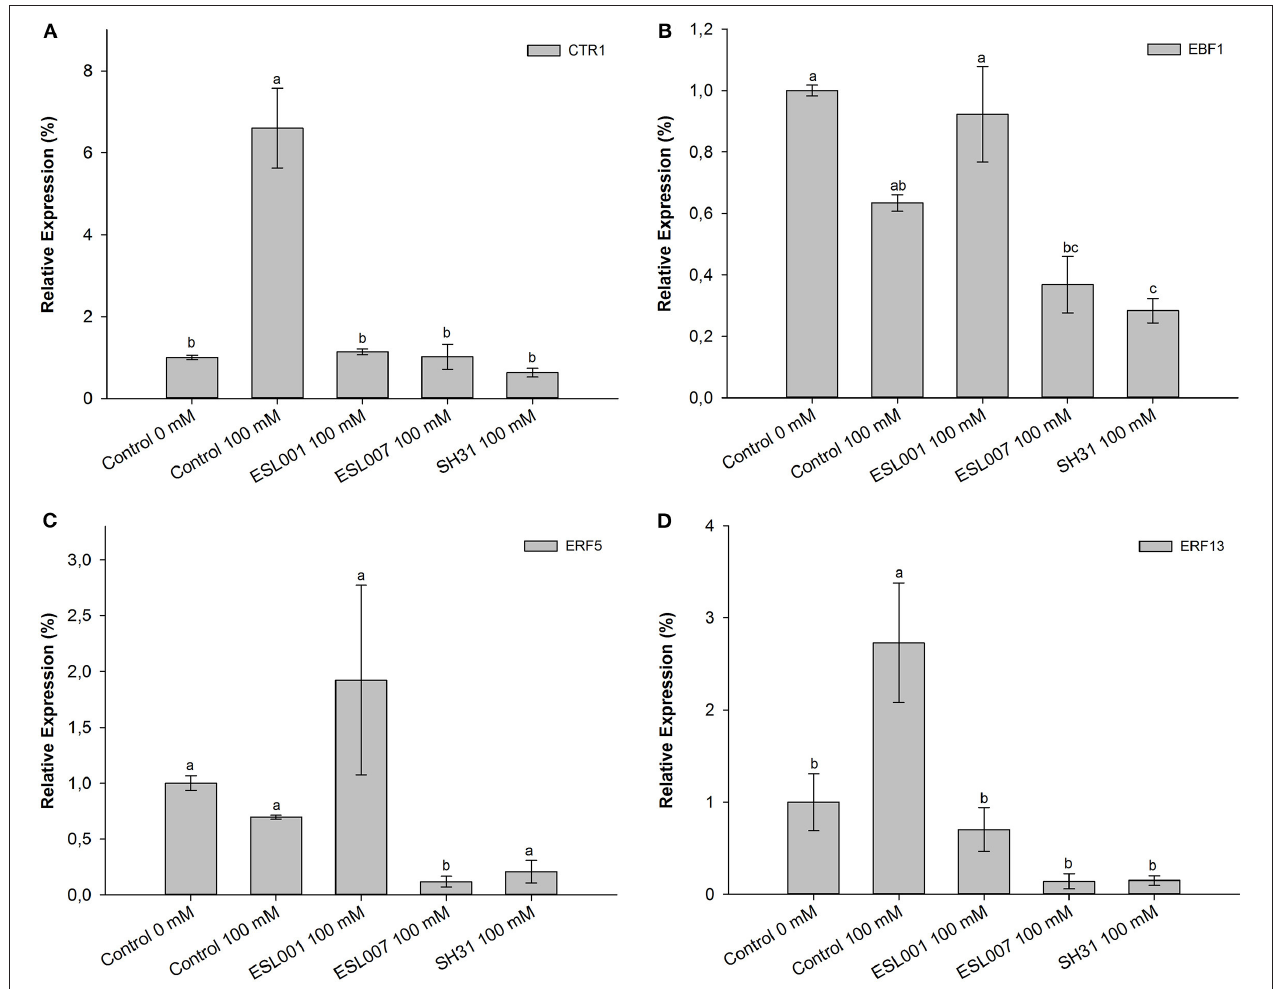
FIGURE 4 | Comparative expression analysis of L. sativa gene homologs involved in ethylene signaling and ethylene-responsive genes. Samples were obtained from leaves of non-inoculated, non-stressed plants (Control 0mM NaCl), non-inoculated plants subjected to 100mM NaCl (Control 100mM NaCl), and salt stressed plants previously inoculated by three different bacterial strains (ESL001 100mM, ESL007 100mM and SH31 100mM NaCl). Relative mRNA levels of CTR1 (A) , EBF1 (B) , ERF5 (C) , and ERF13 (D) gene homologs were quantified by real-time PCR. Elongation Factor 1 α was used as endogenous gene. Results represent the mean value ± standard error (SE). Different letters denote significant statistical differences ( p < 0.05). Data are the means of three biological